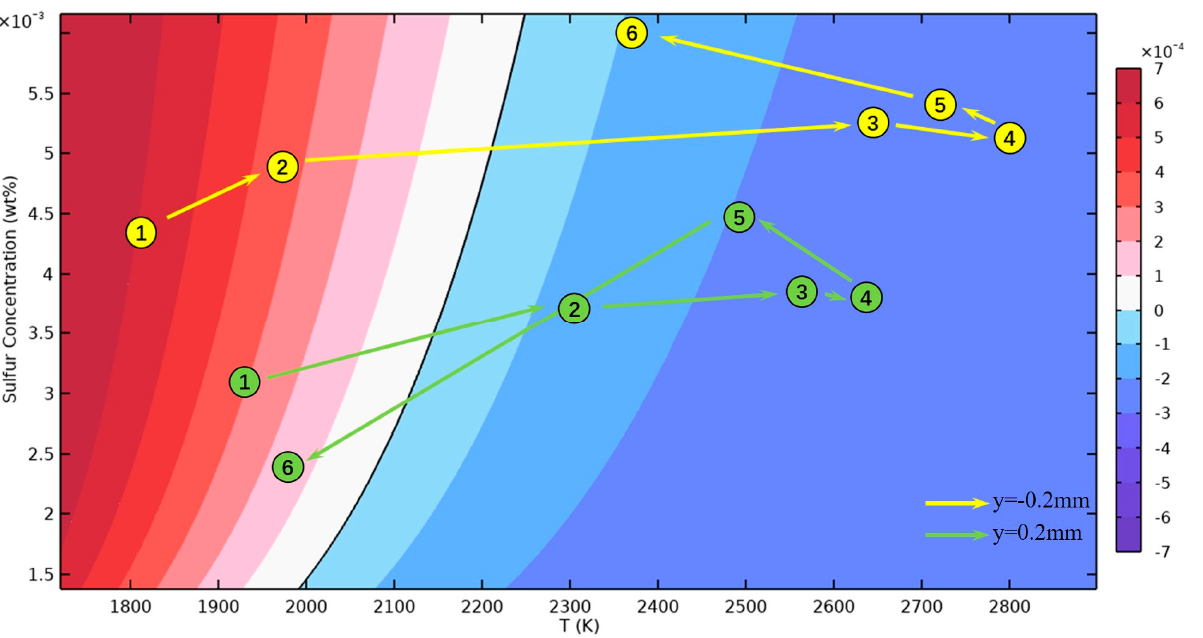
Figure 8. TCST at di ff erent temperatures and sulfur concentrations.